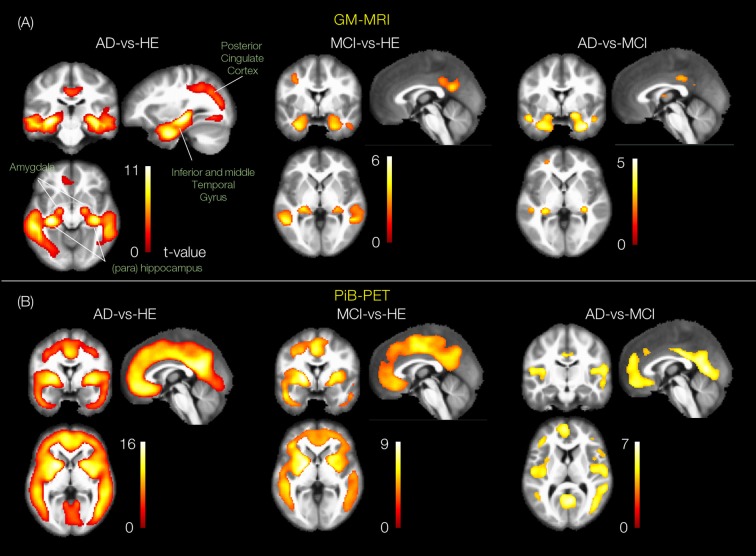
Group statistical differences of the group pairs for GM-MRI and Pittsburgh compound B-positron emission tomography (PiB-PET) volumes. The rendered t-contrast maps obtained from unpaired two sample t-test factorial analysis of three group pairs, AD-vs.-HE, MCI-vs.-HE and AD-vs.-MCI for (A) GM and (B) PiB scans.